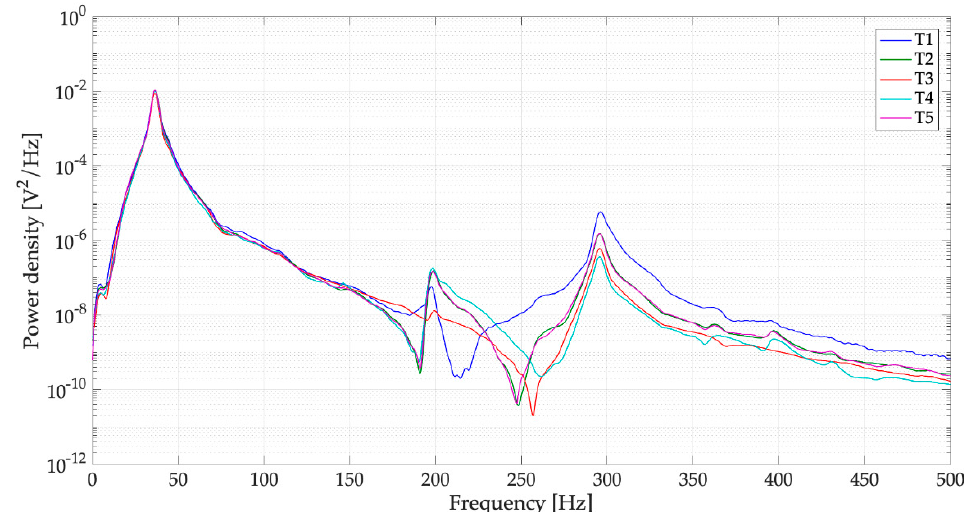
Figure 18. Tests with drops falling from 1 m on the filled spoon, PSDs of on-load voltage. Table 2. Literature values of harvested energy.